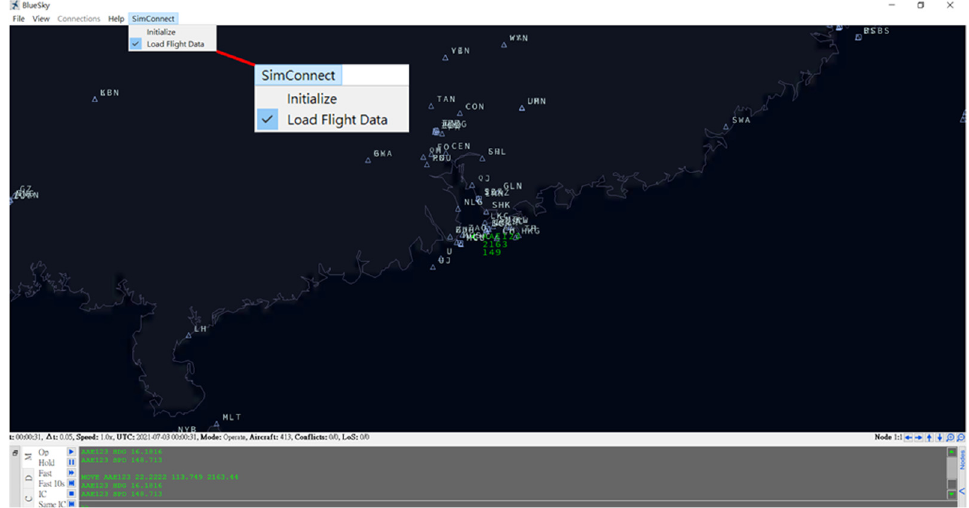
Figure 5. The modified user interface of BlueSky.